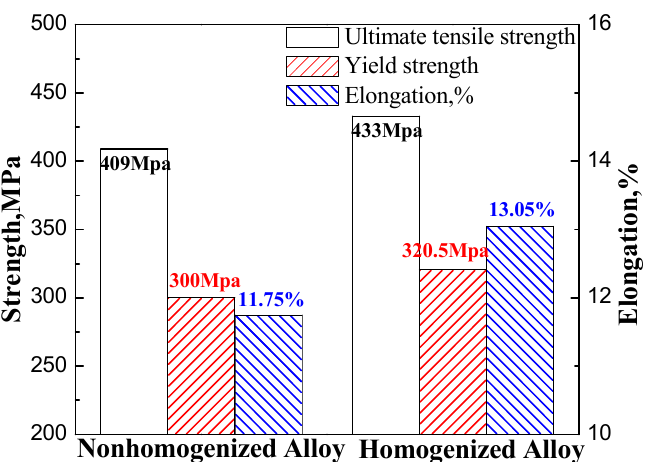
Figure 13. Mechanical properties of 2219 aluminum alloy for as-cast and homogenized sample after forging and T6 treatment.